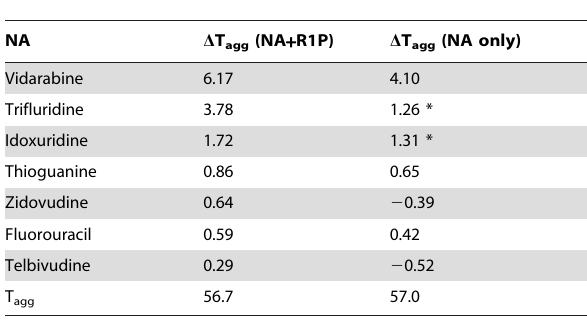
Table 3. Mean D Tagg ( u C) for UPP1.